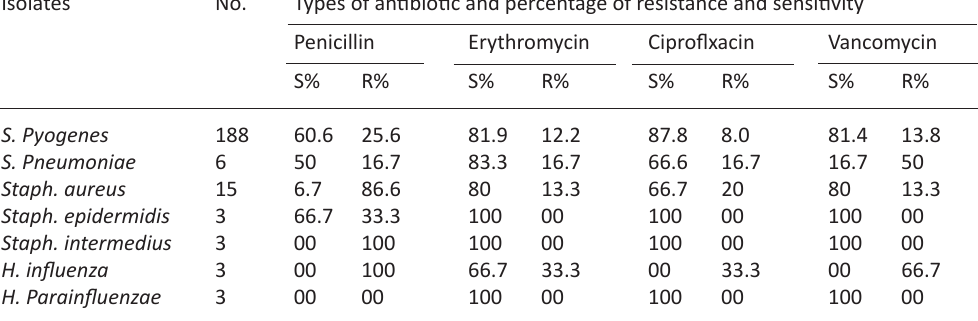
Table 4. percentage of the sensitivity of bacteria isolated from patients with acute suppurative tonsillitis to different antimicrobial agents.